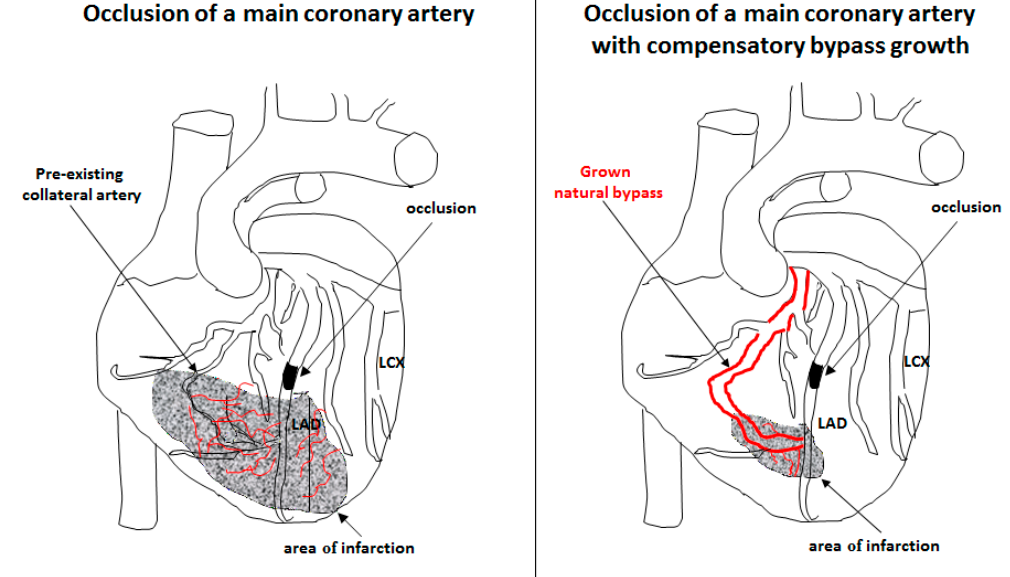
Figure 2. Collateral artery growth. Occlusion of a main coronary artery ( left picture) results in severe ischemic cardiac-tissue damage (area of infarction) associated with extensive capillary sprouting in order to remove cell debris. If the loss of the occluded artery is compensated by natural bypass growth (arteriogenesis) ( right picture), the extent of tissue damage and newly formed capillary network is strongly reduced. Coronary arteries: Left Anterior Descending (LAD), Left Circumflex (LCX). Adapted from Deindl et al. 2006 [63], with the permission of The FASEB Journal .